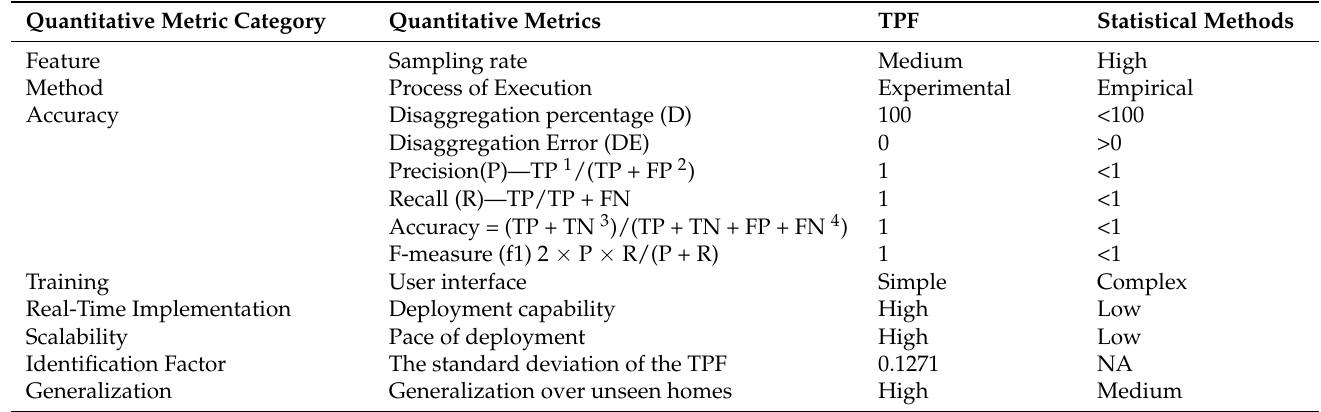
Table 5. Quantitative metrics for the non-intrusive identification of appliance usage patterns in comparison with those of statistical